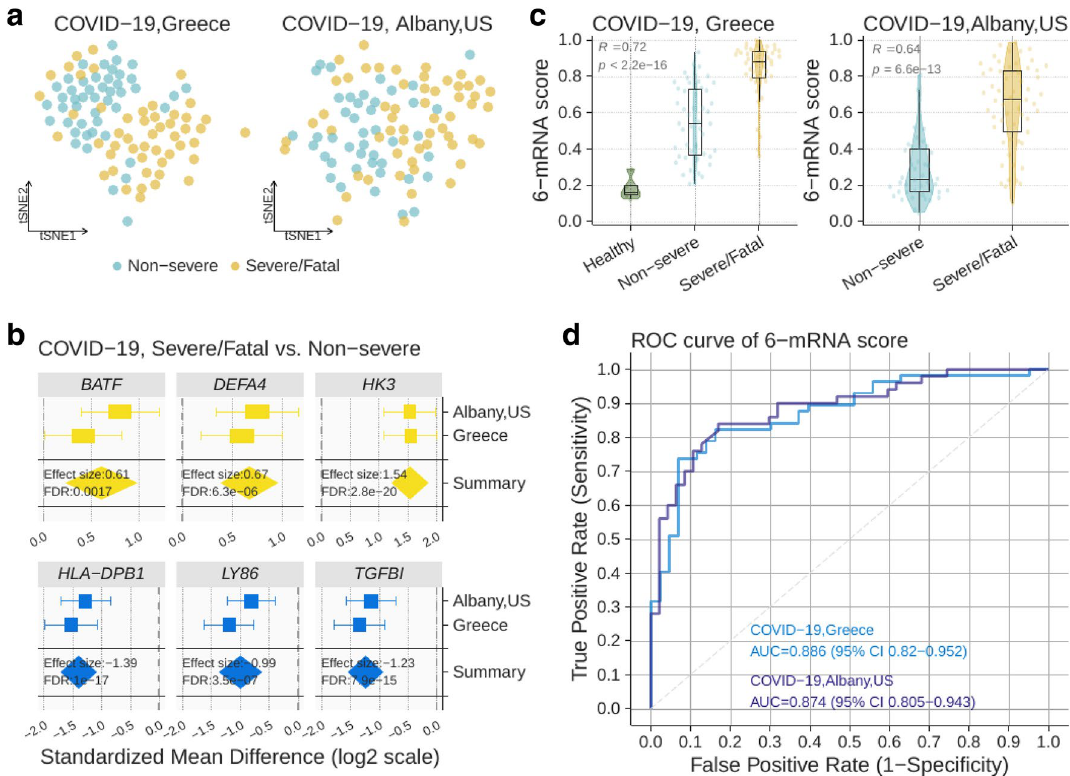
Figure 4. Validation of the 6-mRNA classifier in the COVID-19 cohorts. ( a ) Visualization of prospective (Greece, N = 97) and retrospective (Albany, US, N = 100) samples in the independent validation cohorts using t-SNE. ( b ) Expression of the 6 genes used in the logistic regression model in patients with severe/fatal and non-severe SARS-CoV-2 viral infection. ( c ) 6-mRNA classifier accurately distinguishes non-severe and severe patients with COVID-19 as well as those who died. ( d ) ROC plot for non-severe COVID-19 vs. severe or death (samples from healthy controls not expression of the 6 mRNAs (without the classifier) revealed a degree of separation between patients with severe COVID-19 disease and those with non-severe disease (Fig. 4a). When comparing expression of the 6 mRNAs in patients with non-severe COVID-19 disease to those with severe disease, expression of each changed statistically significant in the same direction as the training data in both cohorts (P < 0.05) (Fig. 4b). We applied the locked 6-mRNA classifier to the 97 COVID-19 patients and the 5 healthy controls in the Greece cohort. The 6-mRNA score was correlated with severity in both cohorts (Greece cohort: R = 0.72, P < 2.2e−16; Albany cohort: R = 0.64, P = 6.6e−13) (Fig. 4c). In particular, the model distinguished patients with severe respiratory failure from non-severe patients with an AUROC of 0.89 (95% CI 0.82–0.95) in the Greece cohort, and 0.87 (95% CI 0.80–0.94) in the Albany cohort (Fig. 4d). We also assessed whether the 6-mRNA score is an independent predictor of severity in patients with COVID- 19 by including other predictors of severity (age, SOFA score, CRP, PCT, lactate, and gender) in a logistic regres- sion model. As expected, due to small sample size, and correlations between markers, no markers except SOFA were statistically significant predictors of severe respiratory failure (Supplementary Table 3). For clinical applications, AUROC is a more relevant indicator of marker performance. To that end, we com- pared the 6-mRNA score to other clinical parameters of severity using AUROC (Table 3 and Supplementary Figs. 4, 5). The 6-mRNA score was the most accurate predictor of severe respiratory failure and death except SOFA. The AUROC confidence intervals were overlapping because the study was not powered to detect statisti- cally significant differences. Of note, the 6-mRNA score was significantly more accurate for predicting severe respiratory failure and death than the only assay under the FDA Emergency Use Authorization, the IL-6. As a proxy for assessing how the 6-mRNA score might add to a clinician’s bedside severity assessment, we evaluated whether a combination of our classifier with the SOFA score improves over SOFA alone for the prediction of severe respiratory failure. The two scores together had an AUROC of 0.95; the continuous net reclassification improvement (cNRI) was 0.43 [95% CI 0.04–0.81, P = 0.03]. Together, these results suggest a potential improve- ment in clinical risk prediction when adding the 6-mRNA score to standard risk predictors; but definitive